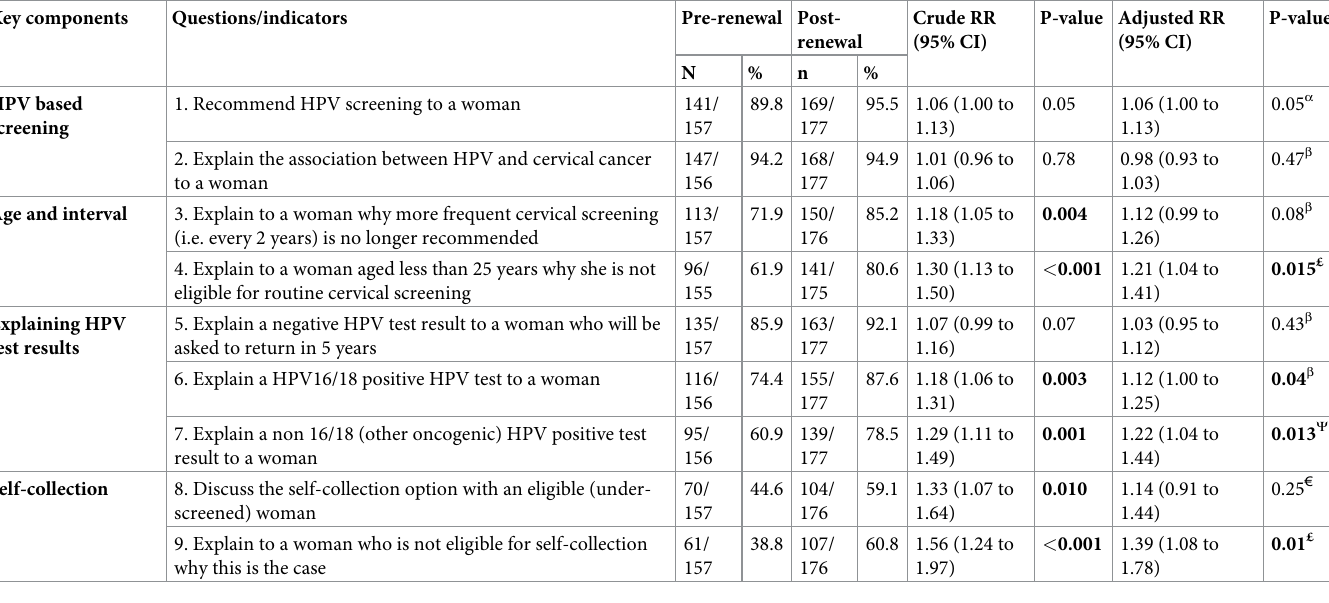
Table 4. Practitioners’ confidence to convey information about the renewed program in pre- and post-renewal samples � . Key